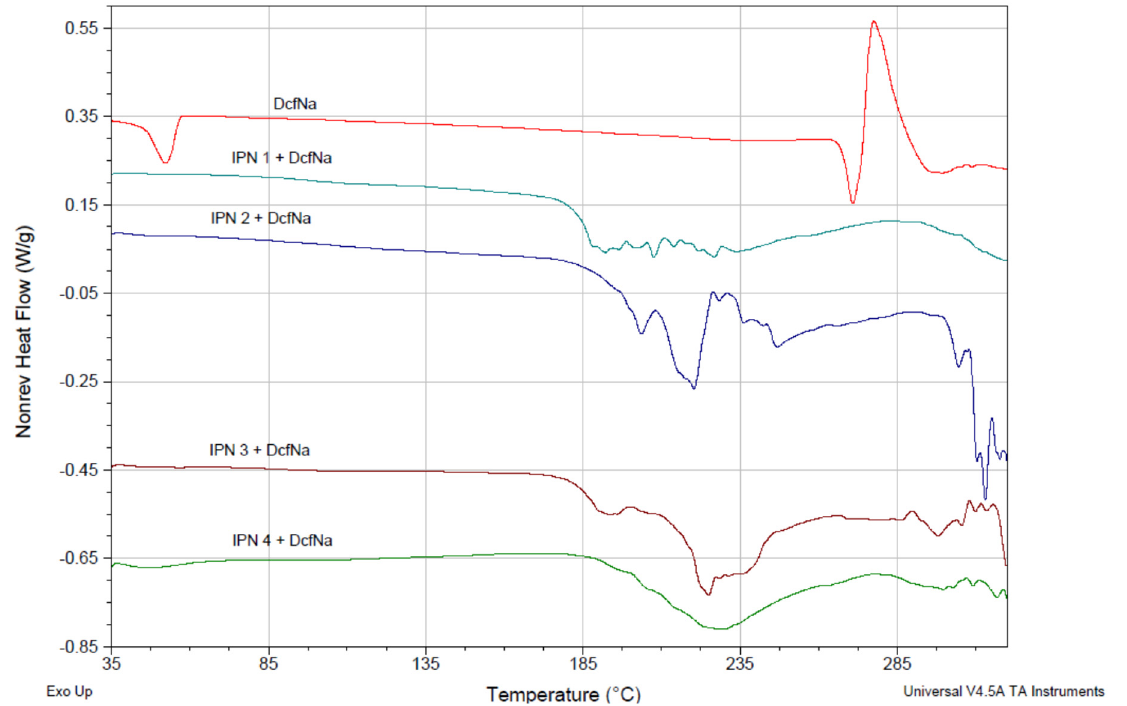
Figure 8. Non-reversing heat flows for diclofenac sodium-pure and loaded in PDMAEMA/PAAm IPNs with different compositions.